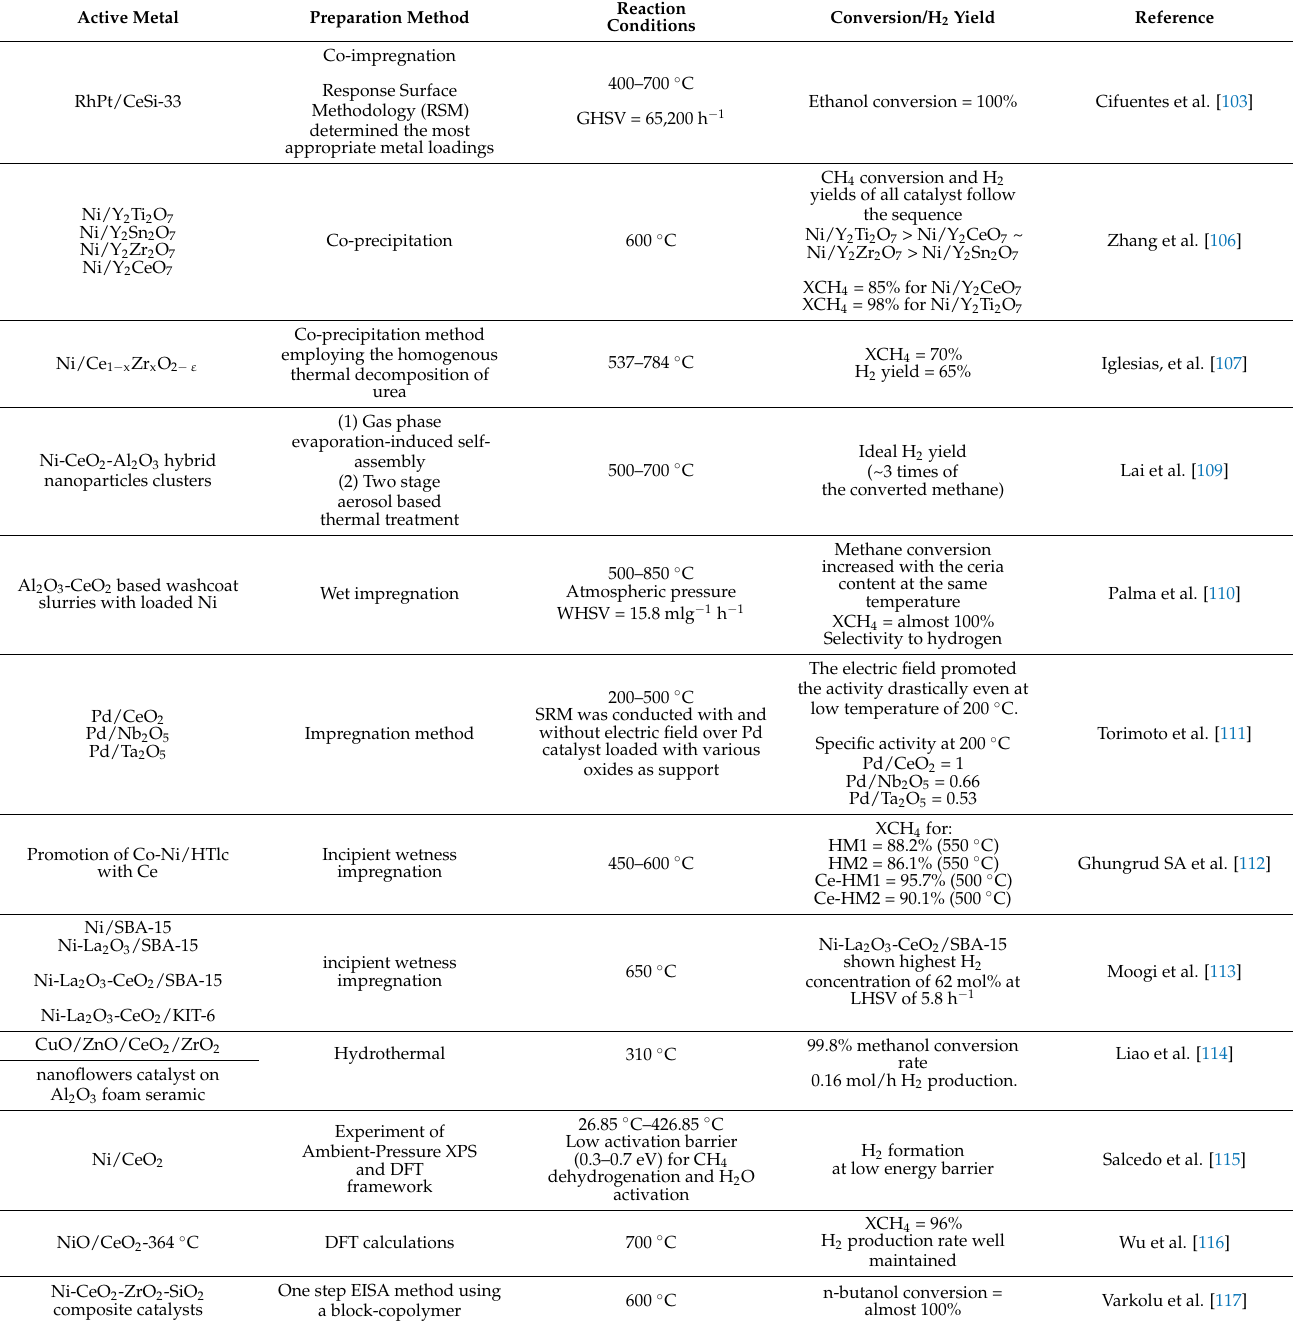
Table 2. Summary of SRM with CeO 2 -based catalysts from 2015 to